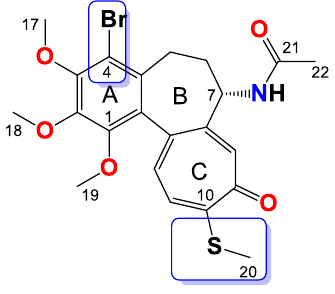
Figure 3. Structure of compound 3 .